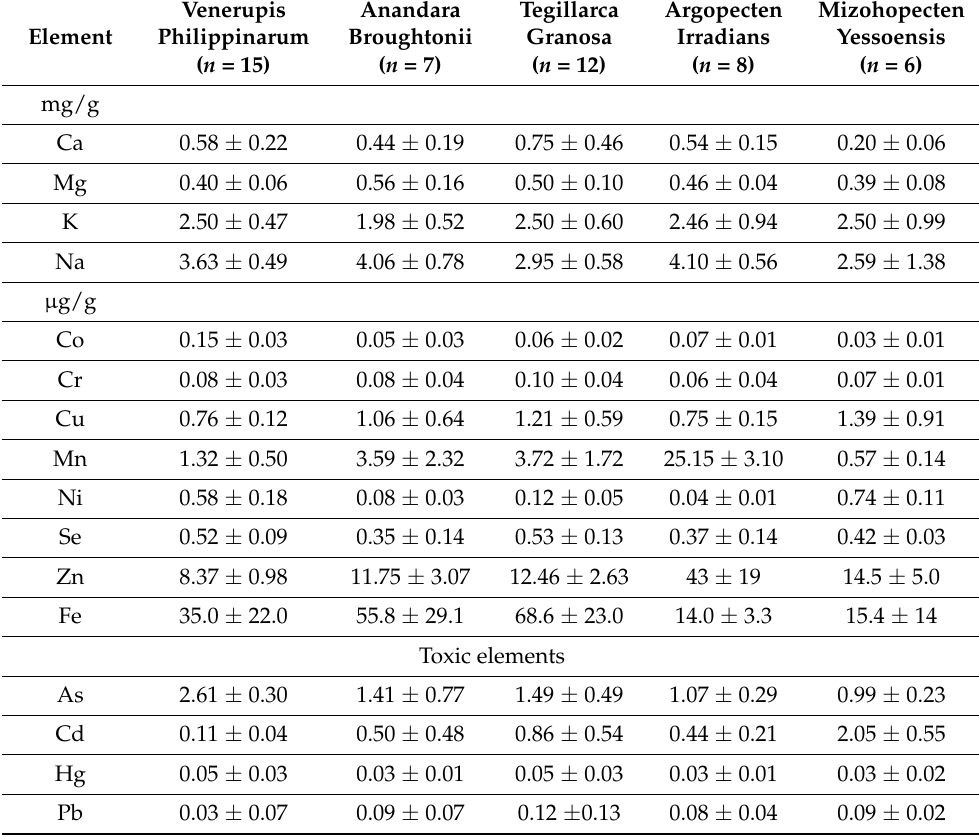
Table 1. Content of macro- (mg/g wet weight), micro-, and toxic elements ( µ g/g wet weight) (mean ± standard deviation) in bivalve